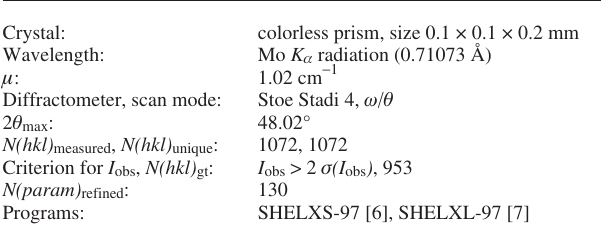
Table 1. Data collection and handling.